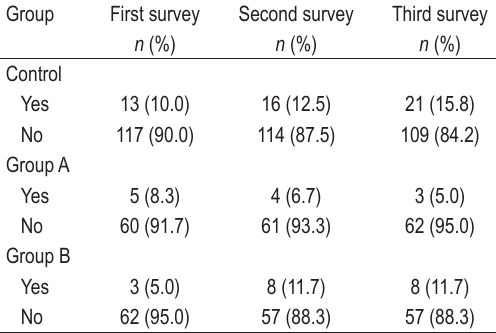
TABLE 3: LIMITATIONS TO DAILY LIVING